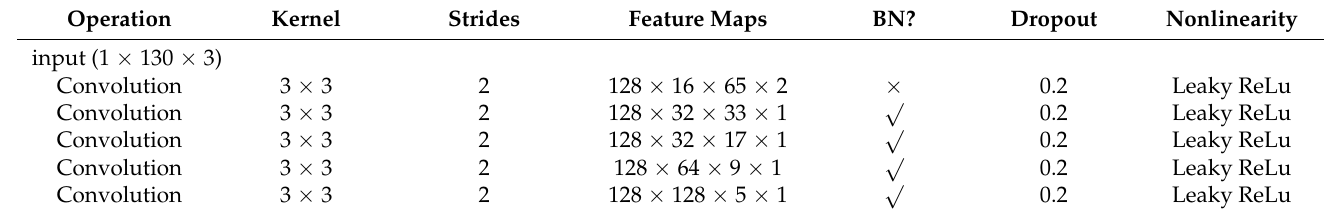
Table 3. Structure of the